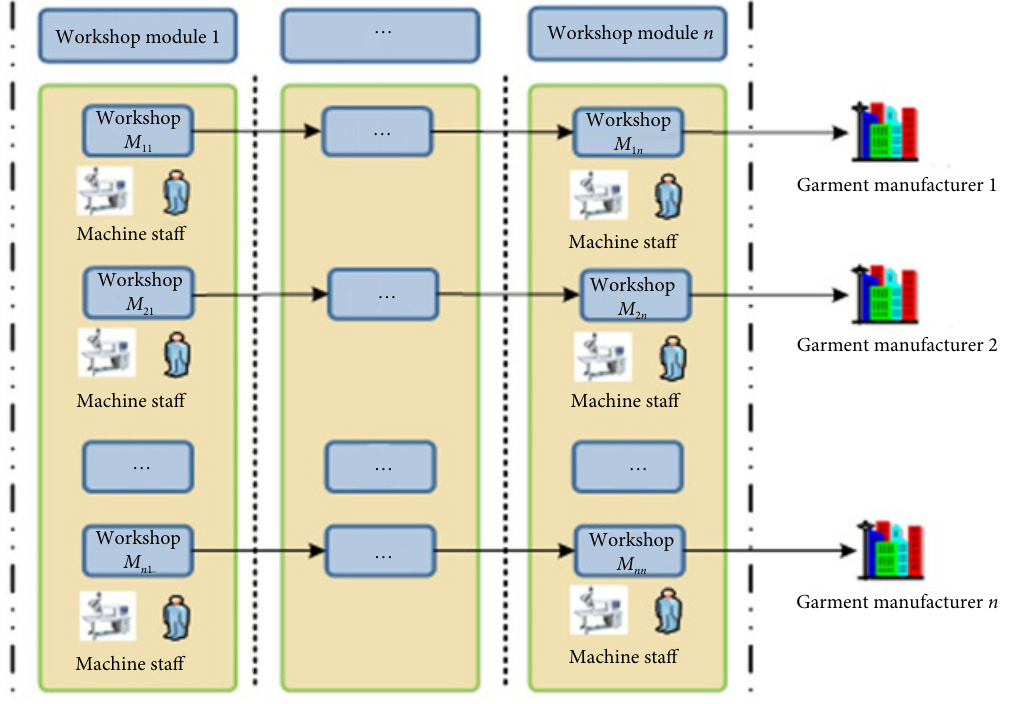
Fig. 3 Organizational structure of